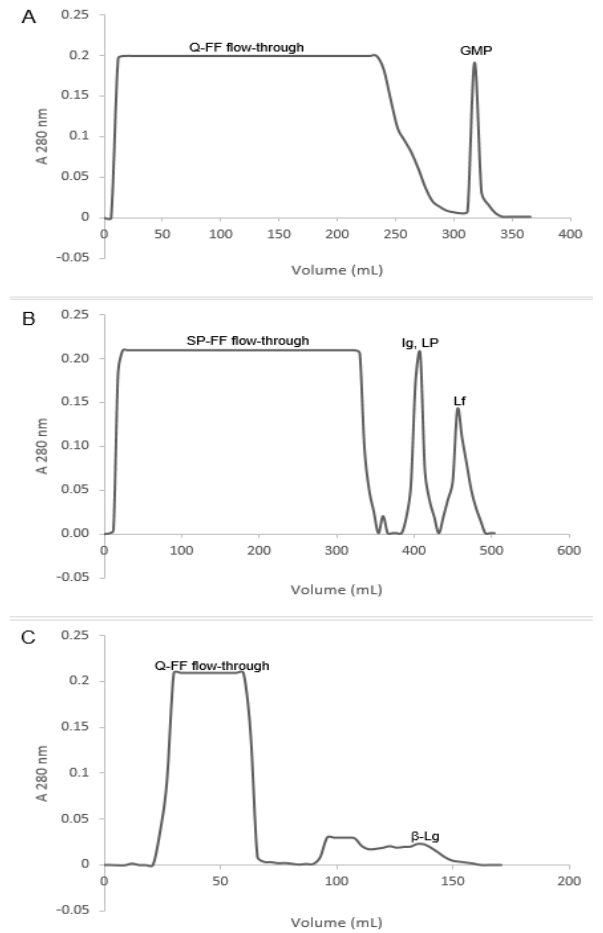
Figure 1. Chromatogram of Lf and β -Lg isolation from red deer milk using a three-step FPLC method. ( A ) First anion exchange chromatography to separate GMP, eluted with 20 mM sodium citrate, 1 M NaCl, pH 3.8. ( B ) Second cation exchange chromatography to separate Ig and Lp, eluted with 20 mM sodium phosphate, 0.4 M NaCl, pH 7; Lf, eluted with 20 mM sodium phosphate, 1 M NaCl, pH 7. ( C ) Third anion exchange chromatography to separate α -La and β -Lg with a linear gradient of 0–50% 20 mM sodium phosphate, 1 M NaCl, pH 8.